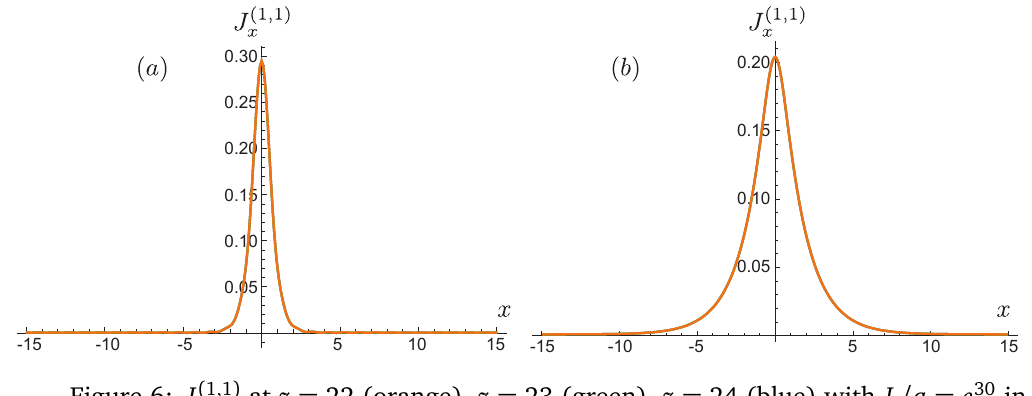
Figure 6: J ( 1,1 ) at z = 22 (orange), z = 23 (green), z = 24 (blue) with L / a = e 30 in x D = 1. We set parameters to be α = 1 and (a) σ = 2.01 and ζ = − 0.1; (b) σ = 0.01 and ζ =